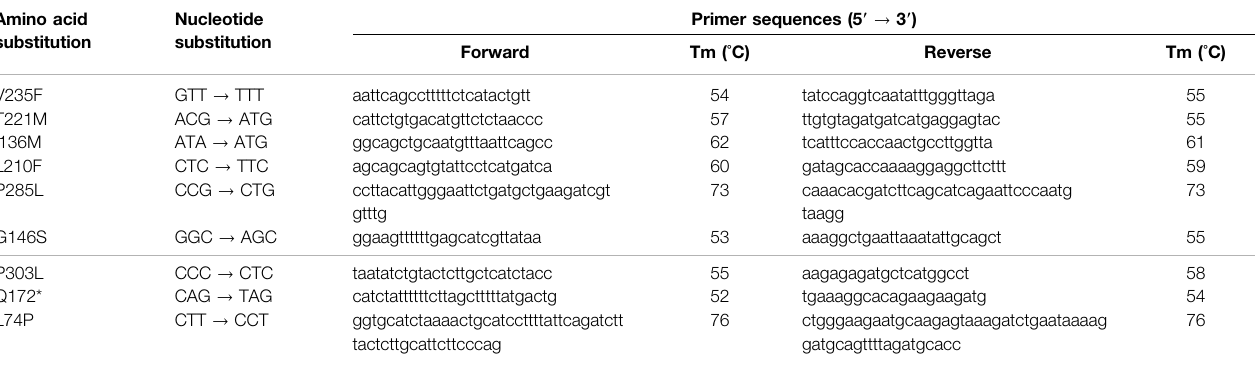
TABLE 2 | Primers used for site-directed mutagenesis of the SLC10A7-v2-mScarlet construct. *, stop codon. Amino acid